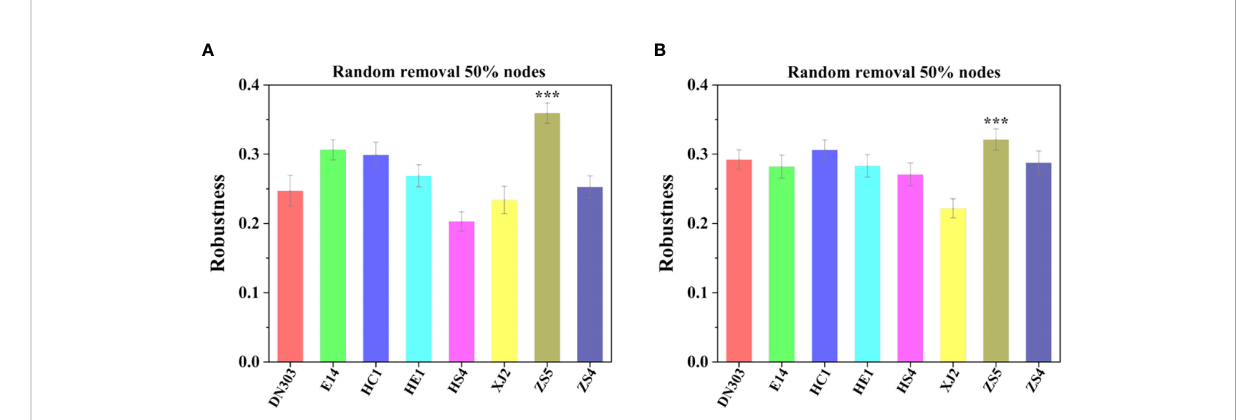
FIGURE 3 Robustness analysis for bacterial and fungal communities among the eight potato cultivars under continues cropping regime. Robustness measured as the proportion of taxa remaining after 50% of the taxa are randomly removed from each of the empirical MENs. (A) The robustness